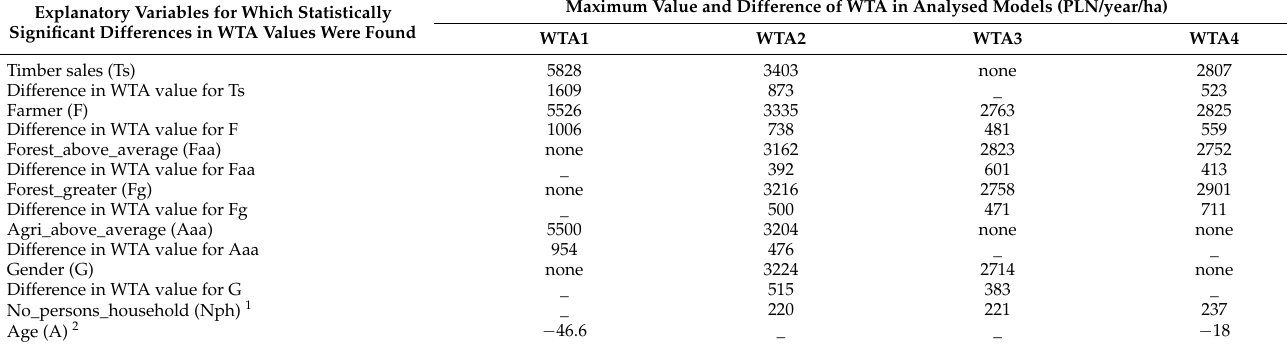
Table 8. Differences in mean WTA values for explanatory variables based on survey research conducted in April 2019 on a random representative nationwide sample of forest owners (farmers). Maximum Value and Difference of WTA in Analysed Models Explanatory Variables for Which Statistically Significant Differences in WTA Values Were Found